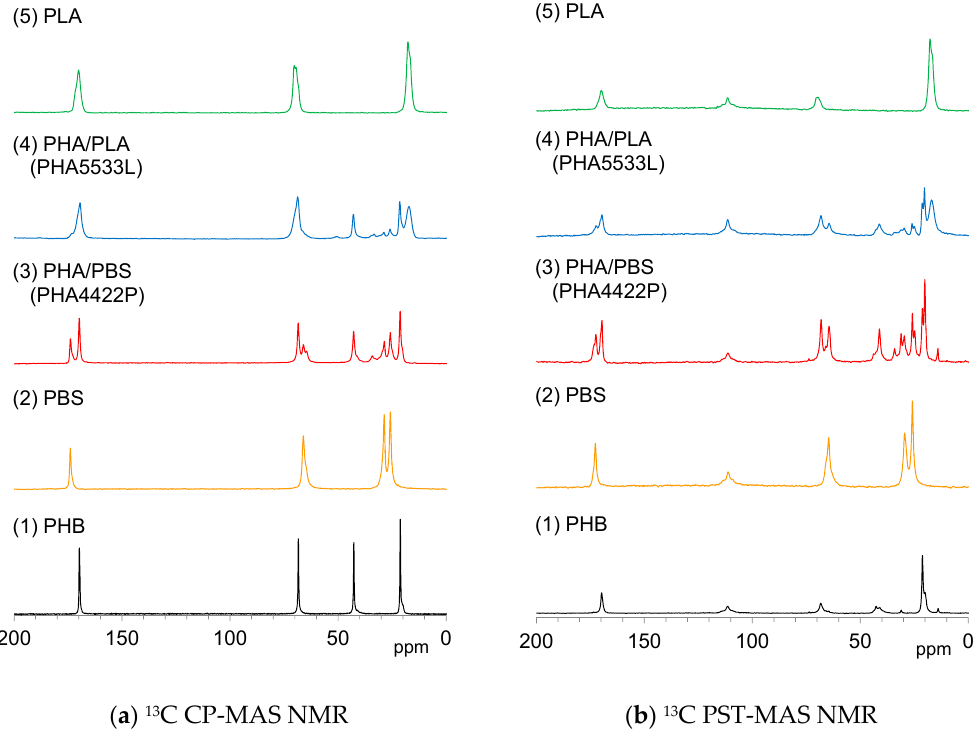
Figure 4. 13 C Magic-angle spinning (MAS) NMR spectra of plasticized PHA copolymers and constituent polymers.